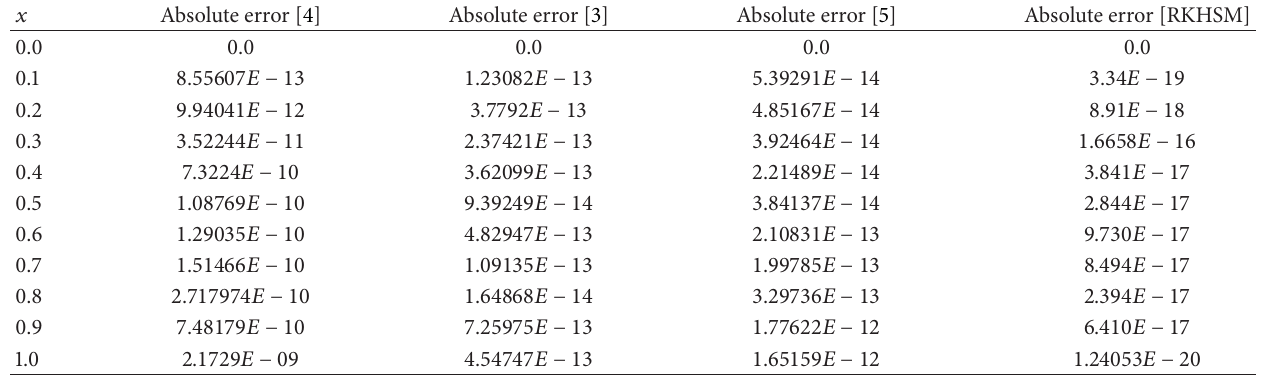
Table 4: Comparison of absolute error of VPM, ADM, HAM, and